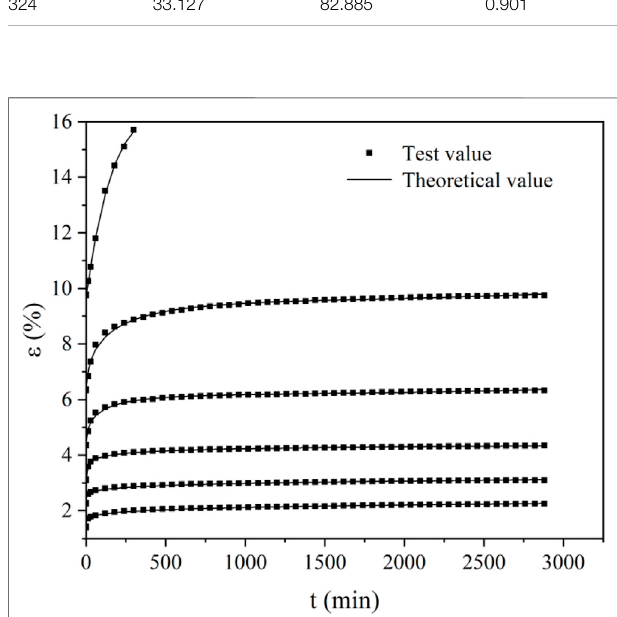
FIGURE 6 | Comparison between theoretical creep curve and tested